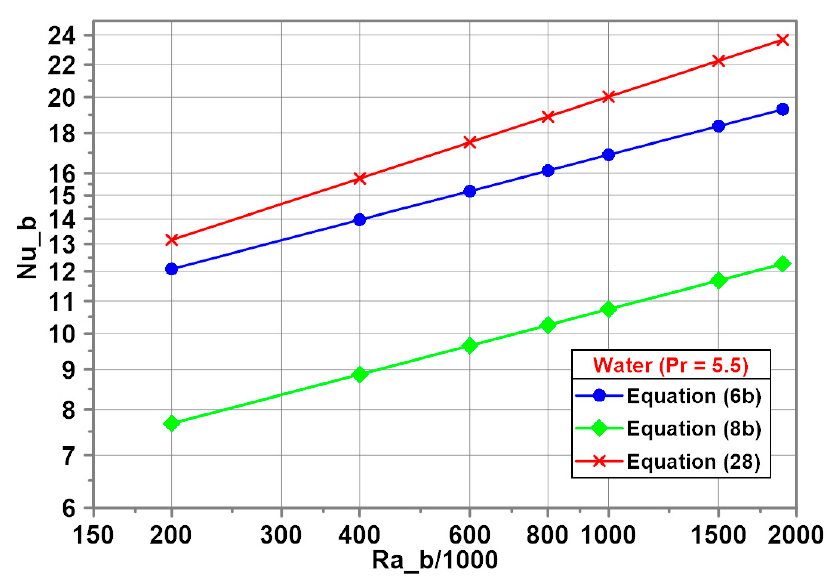
Figure 7. Present Nu-Ra b relationship vs. predictions from literature correlations.